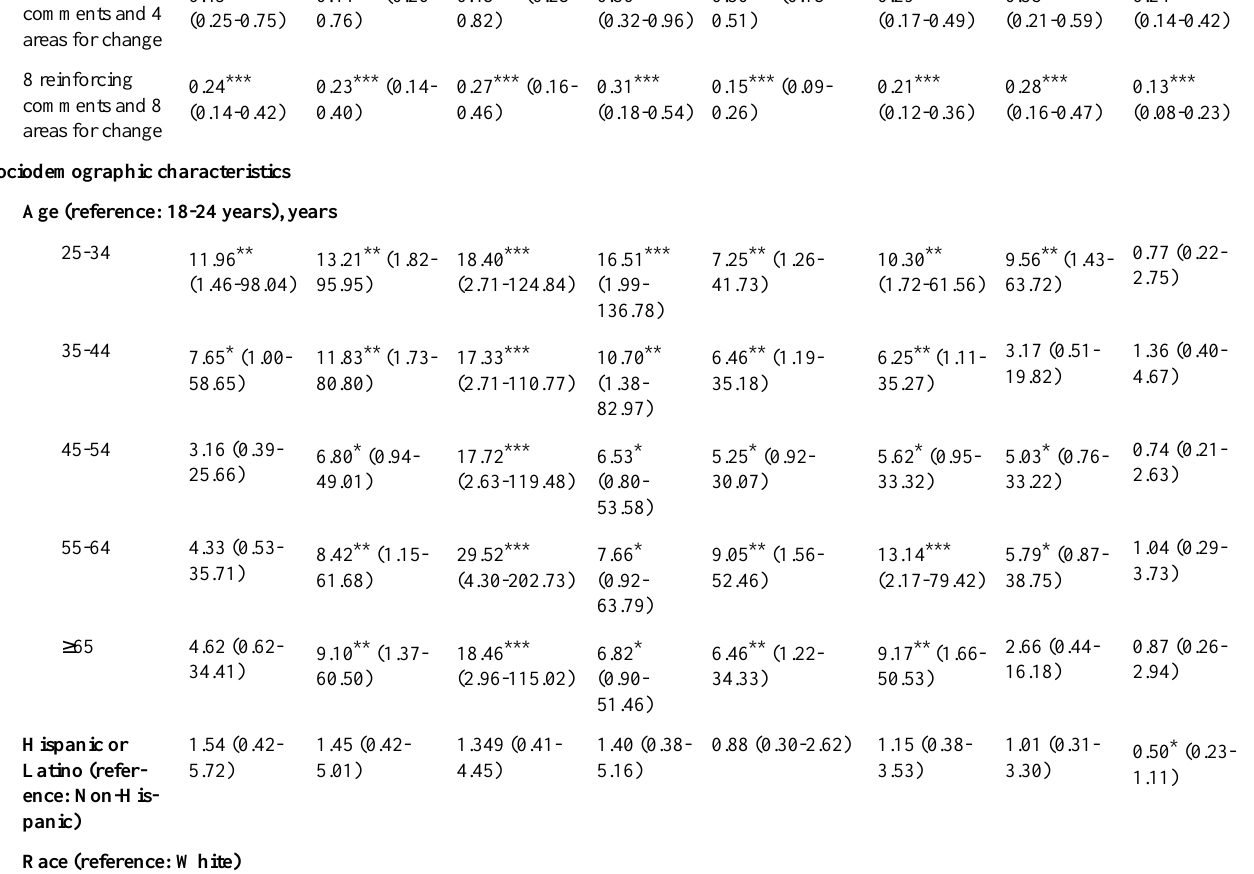
Level of areas for change